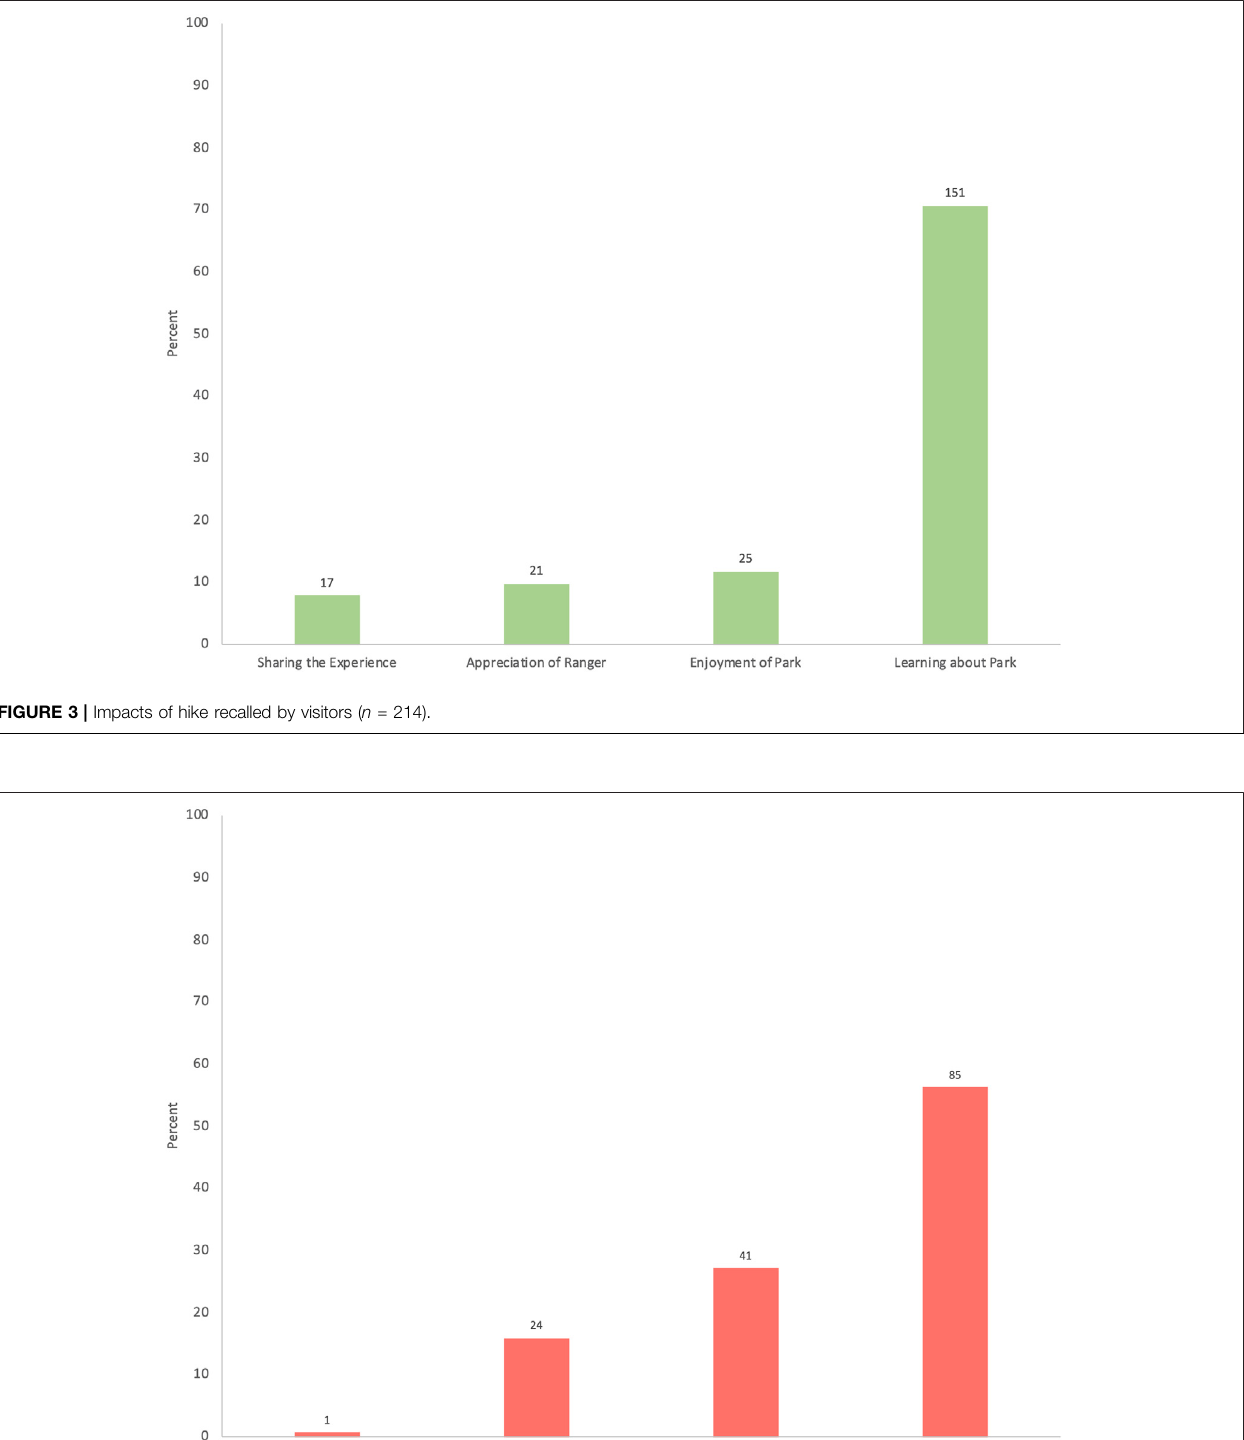
Frontiers in Education |